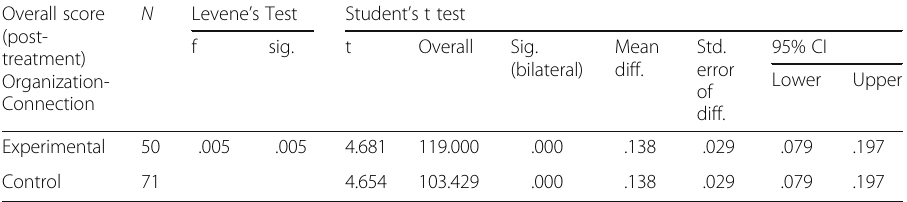
Table 9 Comparative analysis of the mean level of progress in organising and linking ideas (post- treatment)